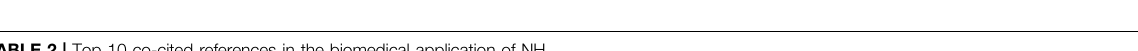
TABLE 2 | Top 10 co-cited references in the biomedical application of